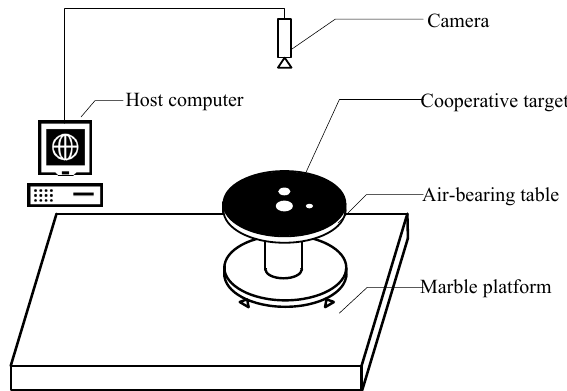
Fig. 1 Schematic diagram of vision-based pose measurement system.